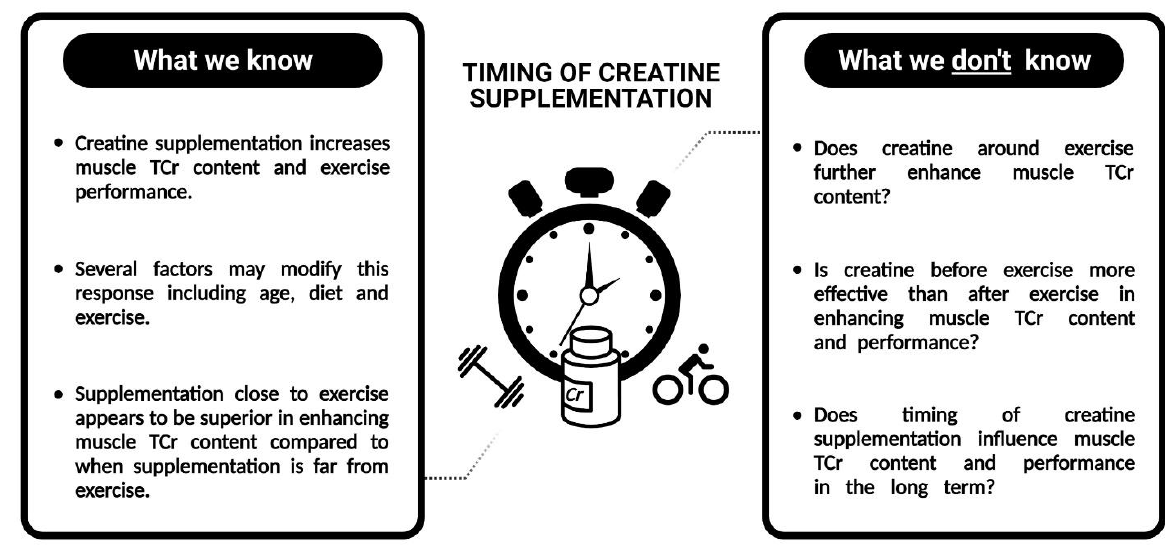
Figure 2. Overview of what is known about the timing of creatine (Cr) supplementation and what is yet to be determined. TCr = total creatine. Created with BioRender.com.